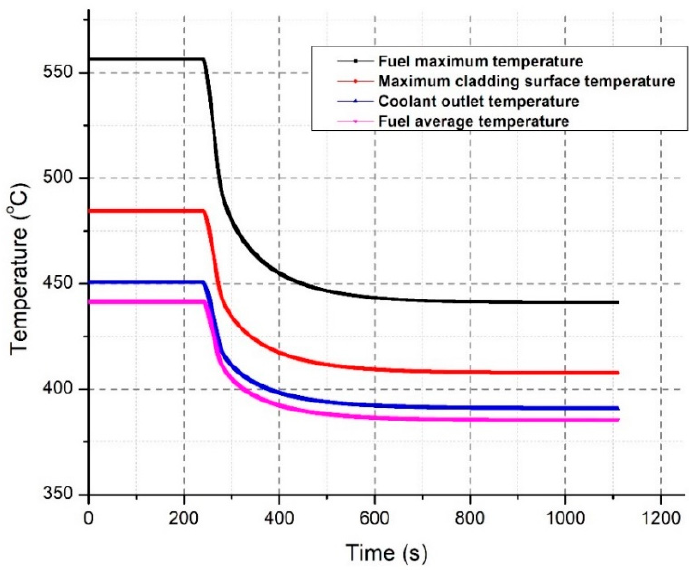
Figure 17. Change in temperatures for a 50% power decrease.